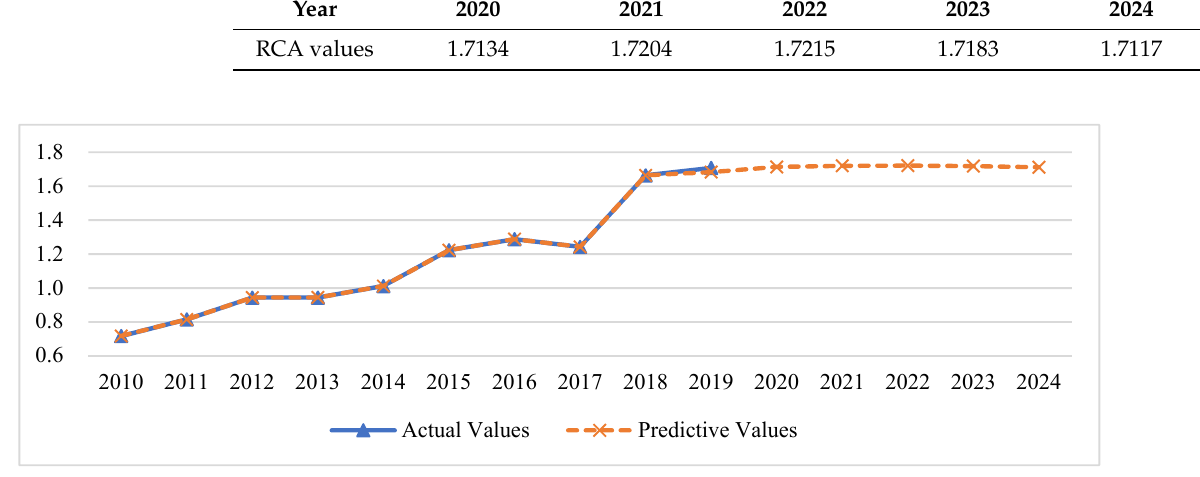
Table 8. Predictive results of international competitiveness of China’s computer information service industry.